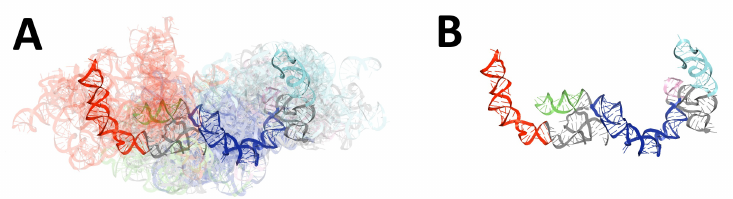
Figure 6. Results of global RMSD-based comparison of RNA 3D models predicted for 3 (cid:48) -UTR regions of SARS-CoV-2. Domains: BSL (red), P2 (green), HVR hairpin (light purple), SLM (cyan), HVR stem (blue). The centroid of each ensemble is solid, and the remaining members are transparent. ( A ) The ensemble of non-pseudoknotted 3D RNA structures and ( B ) its centroid.